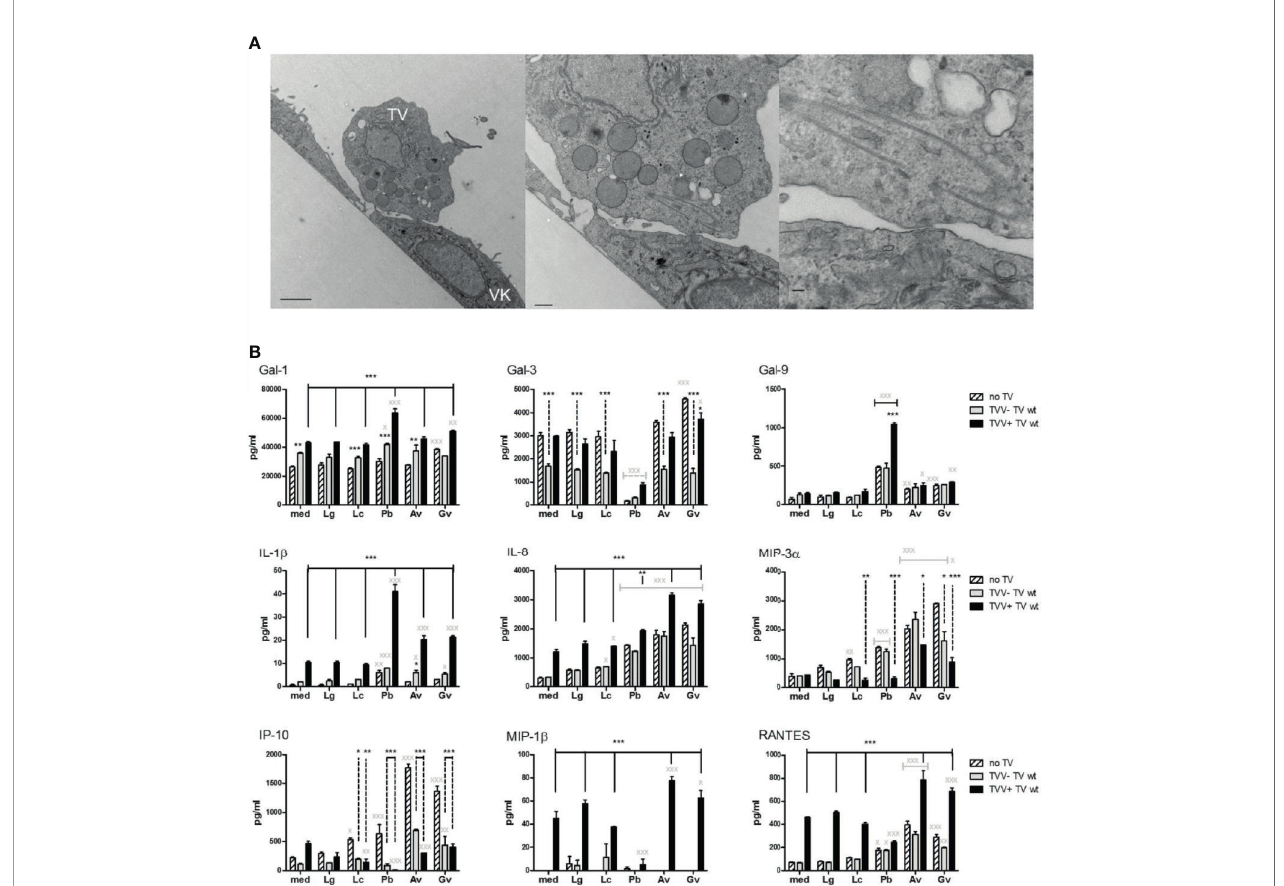
FIGURE 3 | Polymicrobial regulation of galectins and in fl ammatory mediators in a human vaginal infections model. (A) T. vaginalis (TV) adherent to human vaginal epithelial cells illustrated by transmission electron microscopy. (B) Levels of immune mediators measured in the vaginal epithelial supernatants after 24 h colonization with bacteria followed by 24 h exposure to TV. The epithelial cells were fi rst colonized with Lactobacillus species characteristic for the healthy vaginal microbiota ( L. gasseri = Lg and L. crispatus = Lc) or BV bacteria ( P. bivia = Pb, A. vaginae = Av and G. vaginalis = Gv). Then the bacteria-colonized epithelial cells were infected with TV protozoa harboring Trichomonas vaginalis virus (TVV+) or a derivative TV strain that was cured from the virus (TVV − ). Bars represent mean and SD from triplicate cultures in one of three experiments. P values are from ANOVA with Bonferroni multiple comparison test. X, *p < 0.05; XX, **p < 0.01; XXX, ***p < 0.001, different from medium (med)